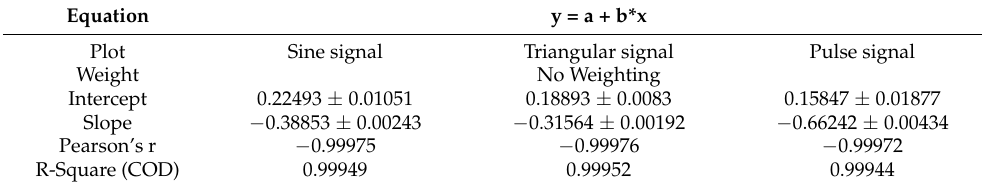
Table 2. Linear fitting parameters of output voltage.